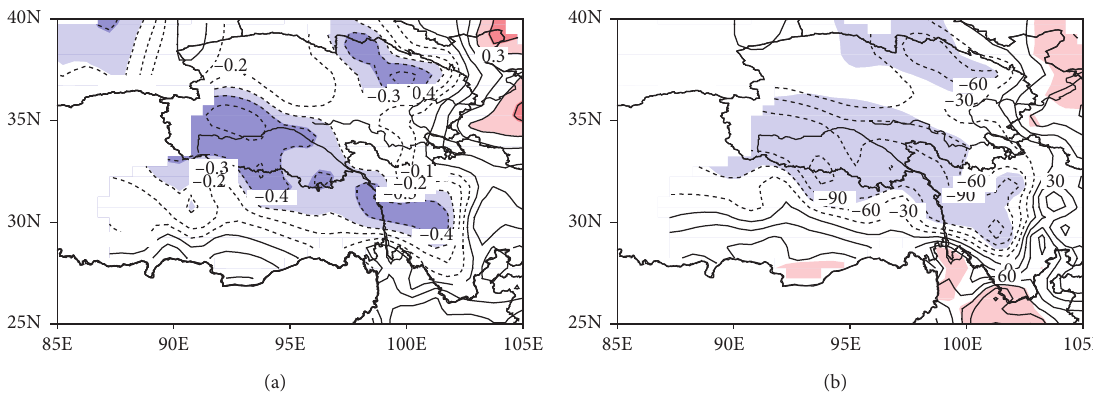
Figure 7: (a) Simultaneous correlation between I W and rainfall. (b) Composite anomalies of the rainfall between the high- I W and low- I W years. The dark (light) shading in (a) indicates correlation coefficients significant at the 99% (95%) confidence level. The shading in (b) indicates rainfall anomalies significant at the 95% confidence level.